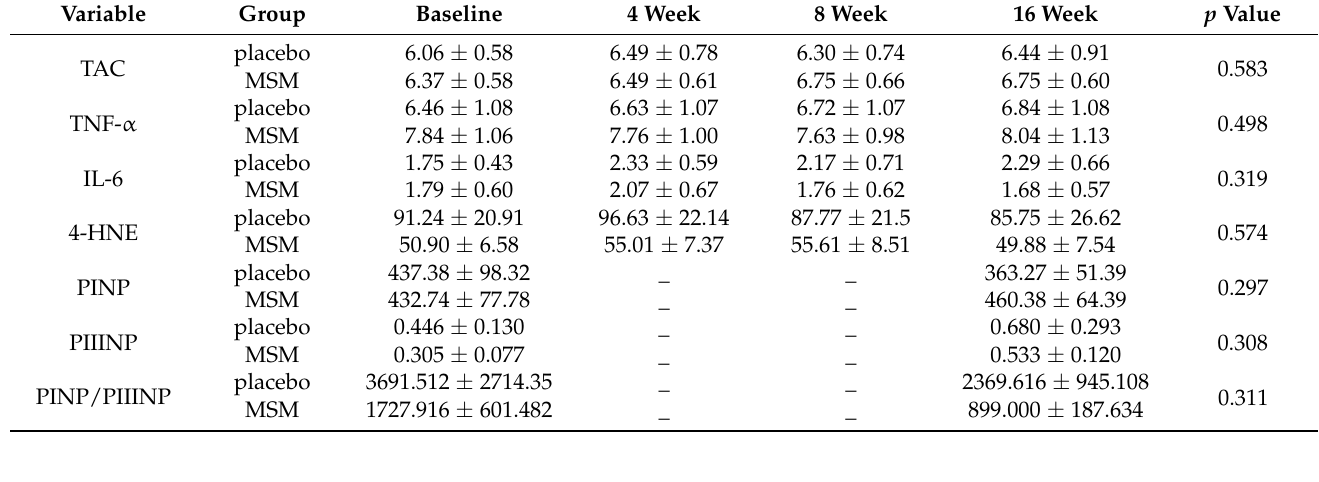
Table 3. Markers of inflammation, oxidative status, and cardiac fibrosis. All measures expressed relative to total serum protein content. TAC, Total antioxidant capacity; TNF- α , Tumor necrosis factor- α , IL-6, Interleukin-6; 4-HNE, Trans-4- Hydroxy-2-nonenal; PINP, Procollagen I N-terminal peptide; PIIINP, procollagen III N-terminal peptide.